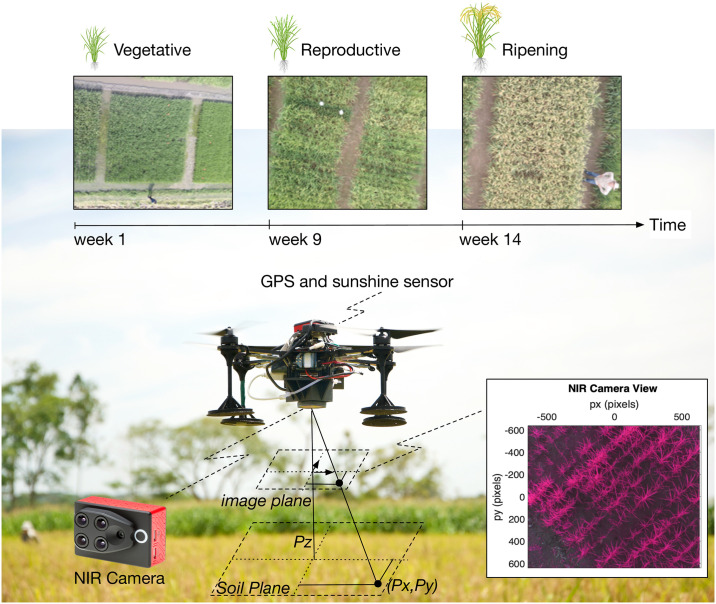
Detailed presentation of the UAV system utilized in this work.